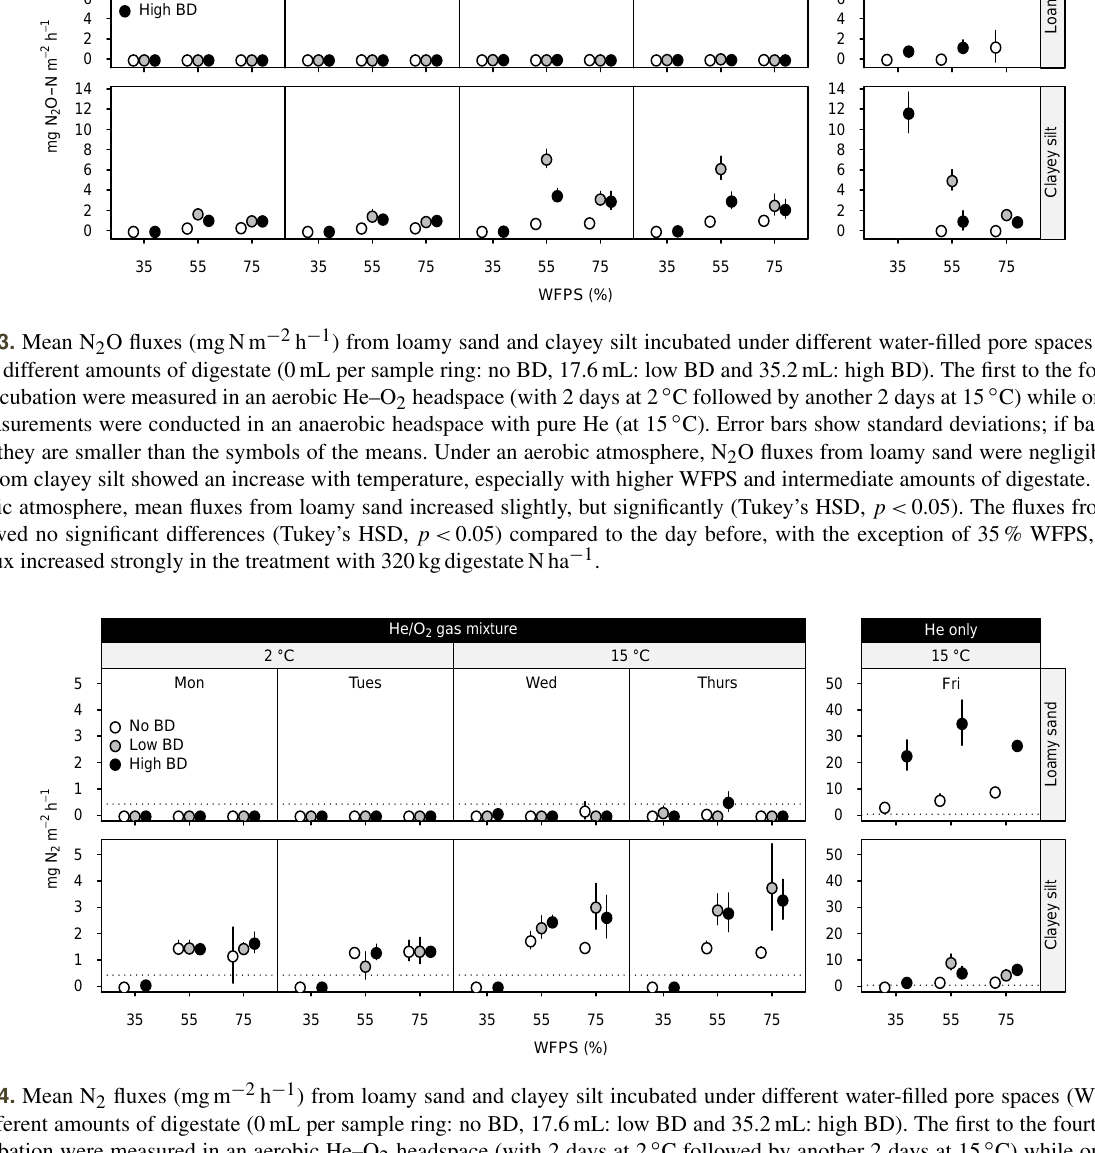
perature and was also identified as significant by regression